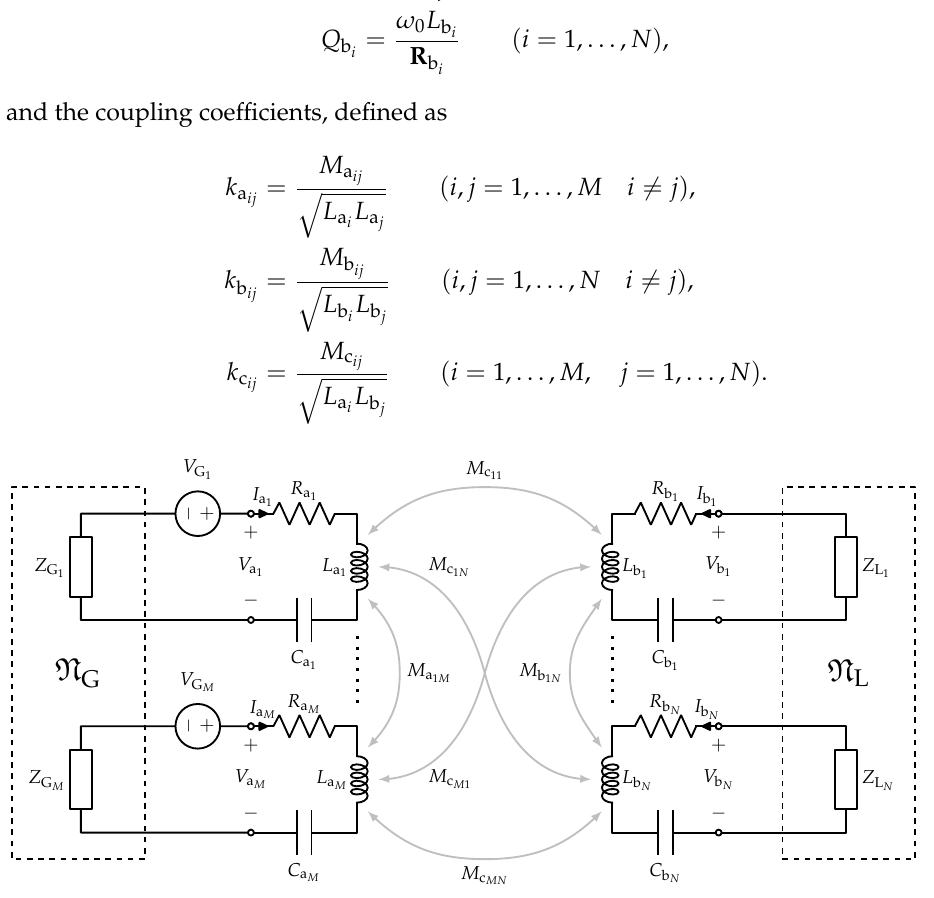
Figure 2. Resonant inductive MIMO WPT